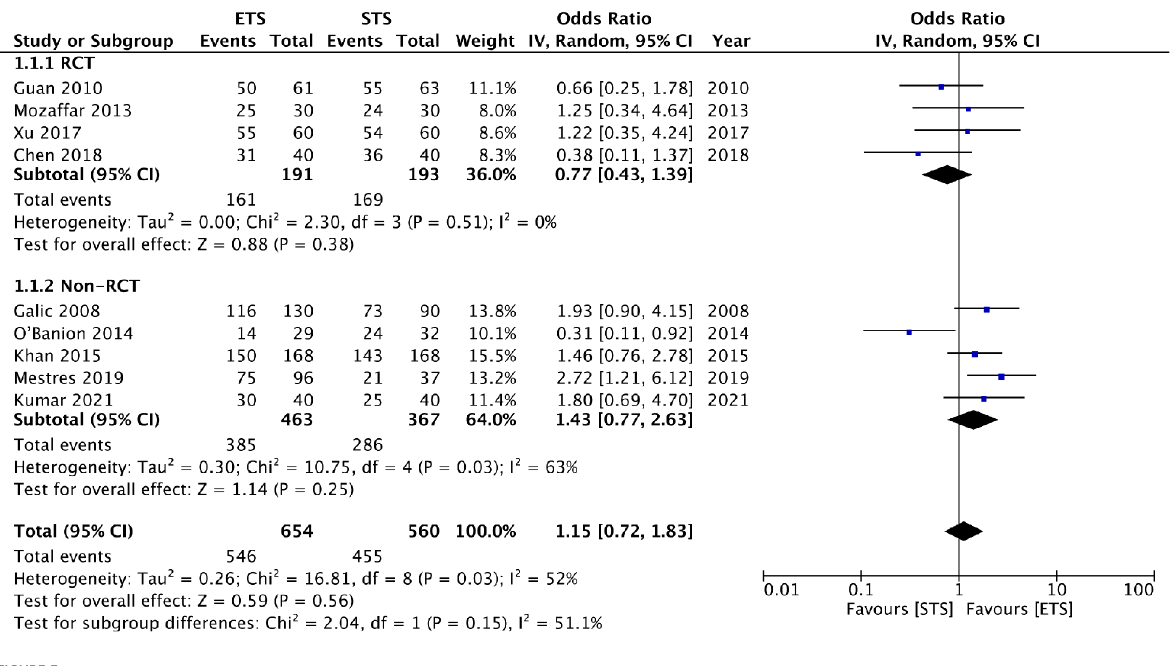
FIGURE 3 Meta-analysis of patency rates at 6 months between ETS and STS groups with subgroup analysis based on type of study.